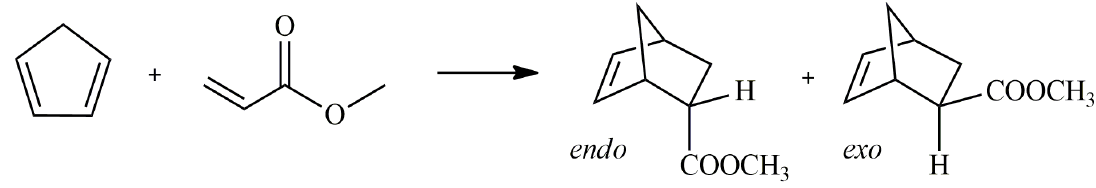
Figure 3. Diels–Alder reaction of cyclopentadiene and methyl acrylate. The studies were extended to explore ILs containing a borenium cation combined with 4-picoline (4pic), 1-methylimidazol (mim) or dimethylacetamide (dma) and [GaCl 4 ] − or [Ga 2 Cl 7 ] − as the counterion. For each of them, the maximum conversion of ethyl